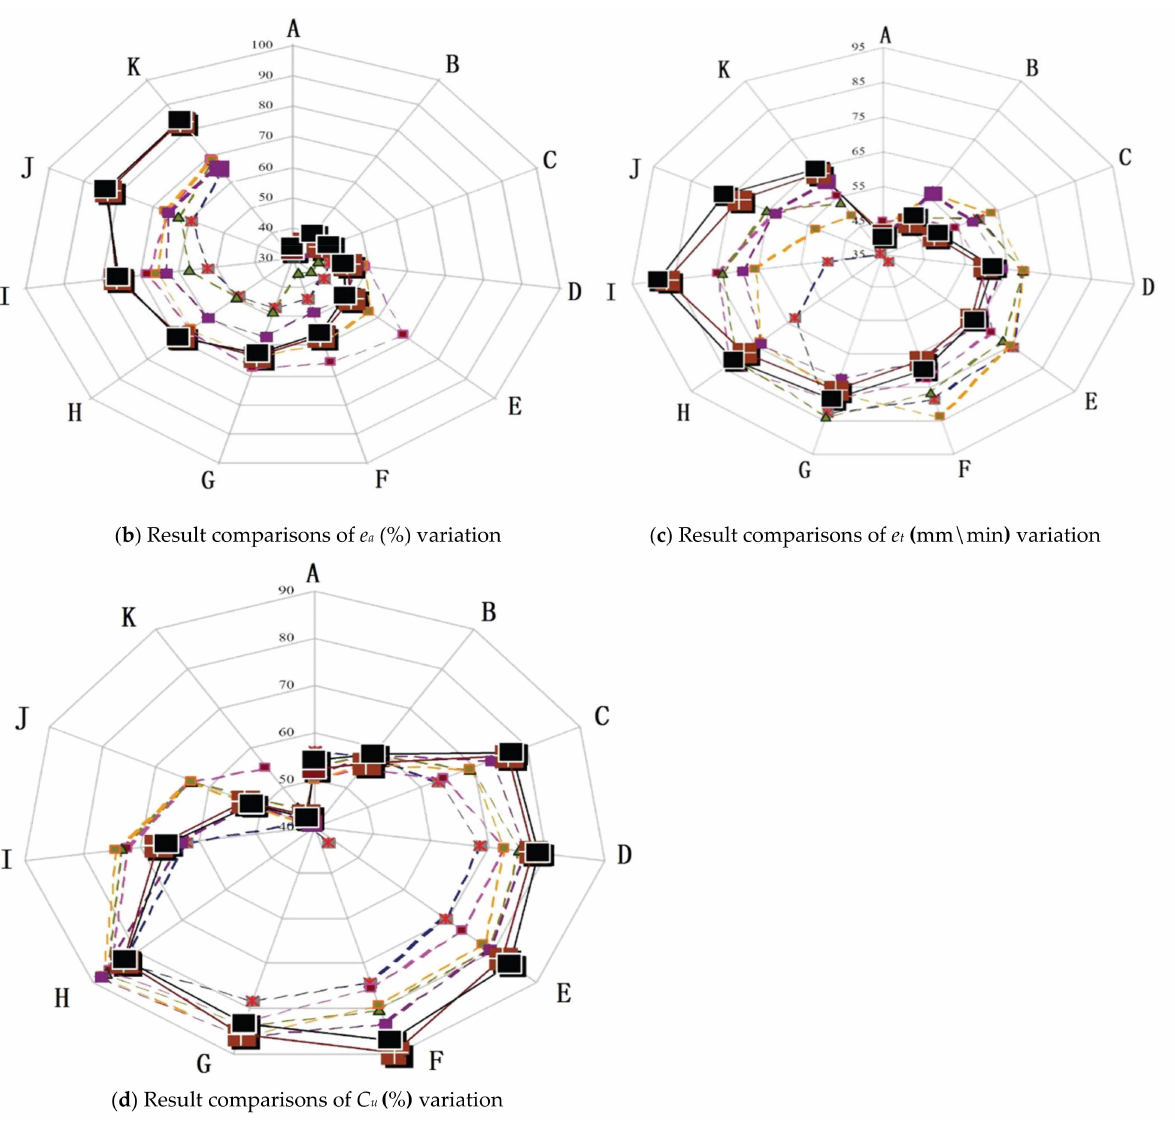
Figure 9. Value comparisons of θ , e a , e t and C u between the predicted and actual measured results originating from tests A–K. Where Figure 9 ( a ) denotes the data variation trend of average soil moisture depth increment ( θ , mm), Figure 9 ( b ) denotes the irrigation infiltration efficiency ( e a ), Figure 9 ( c ) denotes the ratio of net infiltrated moisture depth per unit of irrigation time ( e t , mm/min), and Figure 9 ( d ) denotes the uniformity coefficient of soil moisture infiltration ( C u , %). Besides, Genetic method denotes genetic optimization, SA-GA stands for the simulated annealing- genetic algorithm, Taguchi is Taguchi parameter estimation method, ANN-SA denotes the artificial neural network- simulated annealing prediction method, and GONN stands for the genetically optimized neural